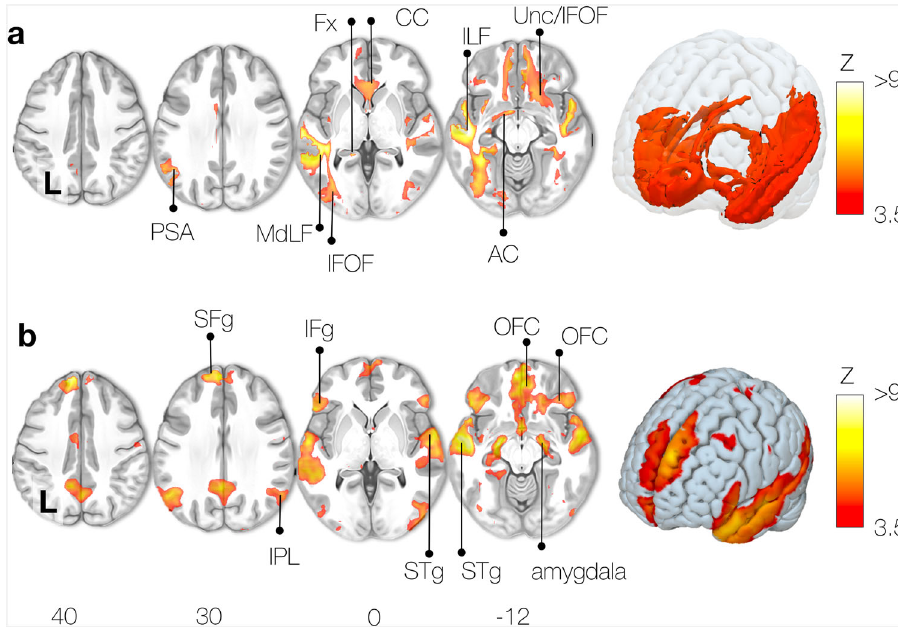
Fig. 6 Semantic system task activation network. a Functionnectome-derived activation map, ( b ) Classic fMRI activation map. PSA: Posterior Segment of the arcuate fasciculus, MdLF: Middle Longitudinal Fasciculus, IFOF: Inferior Fronto-Occipital Fasciculus, Fx: Fornix, CC: Corpus Callosum, ILF: Inferior Longitudinal Fasciculus, Unc: Uncinate fasciculus, AC: Anterior Commissure, SFg: Superior Frontal gyrus, IFg: Inferior Frontal gyrus, IPL: Inferior Parietal Lobe, STg: Superior Temporal gyrus, OFC: orbital frontal cortex, hipp